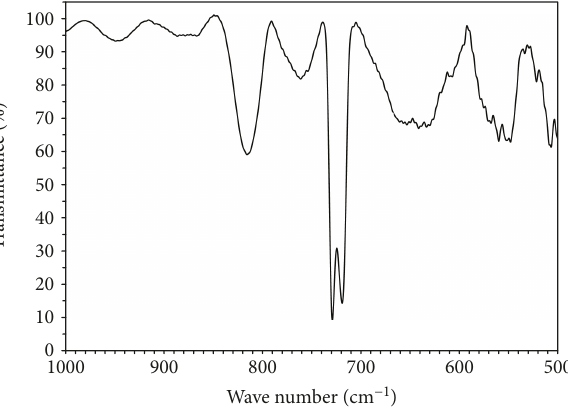
Ti O nanoparticles. 2 2 7